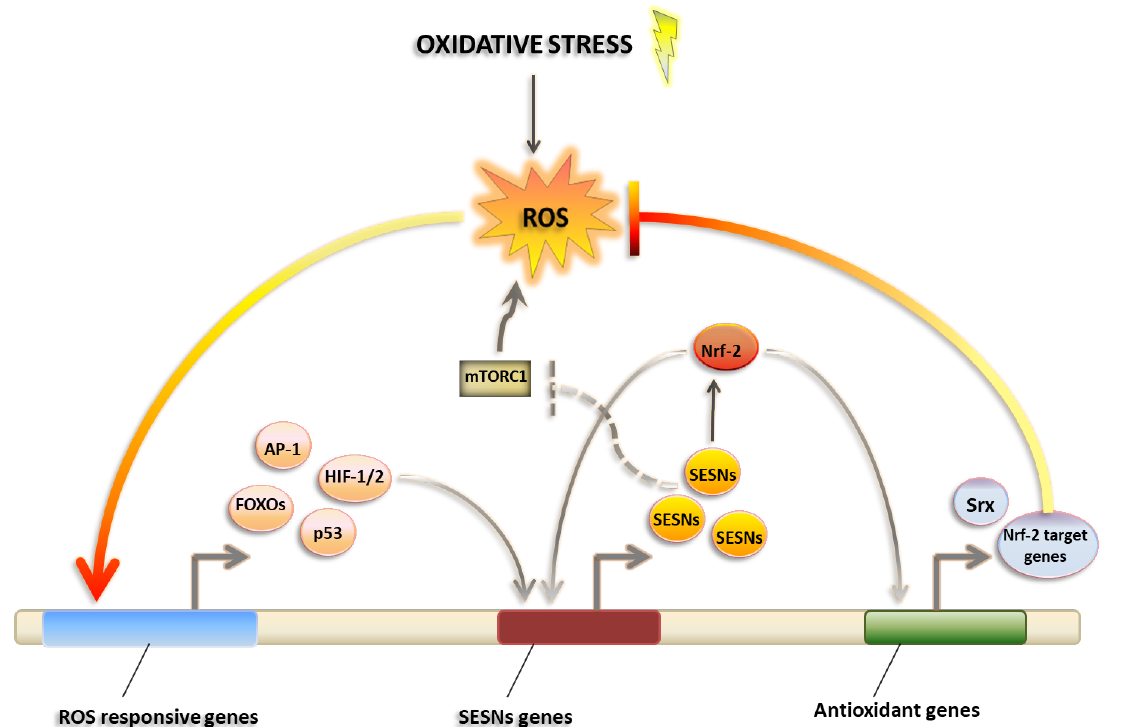
Figure 1. Sestrins as master regulators of Reactive Oxygen Species (ROS) management. Sestrins expression is induced upon oxidative stress and leads to antioxidant response. Increased ROS levels in cells activate ROS-responsive genes including transcription factors AP-1, FOXOs, HIF-1 / 2 and p53, which in turn induce the transcription of SESNs genes. SESNs coordinate antioxidant responses by activating Nrf-2, a transcription factor leading expression of Nrf-2 target antioxidant genes. In